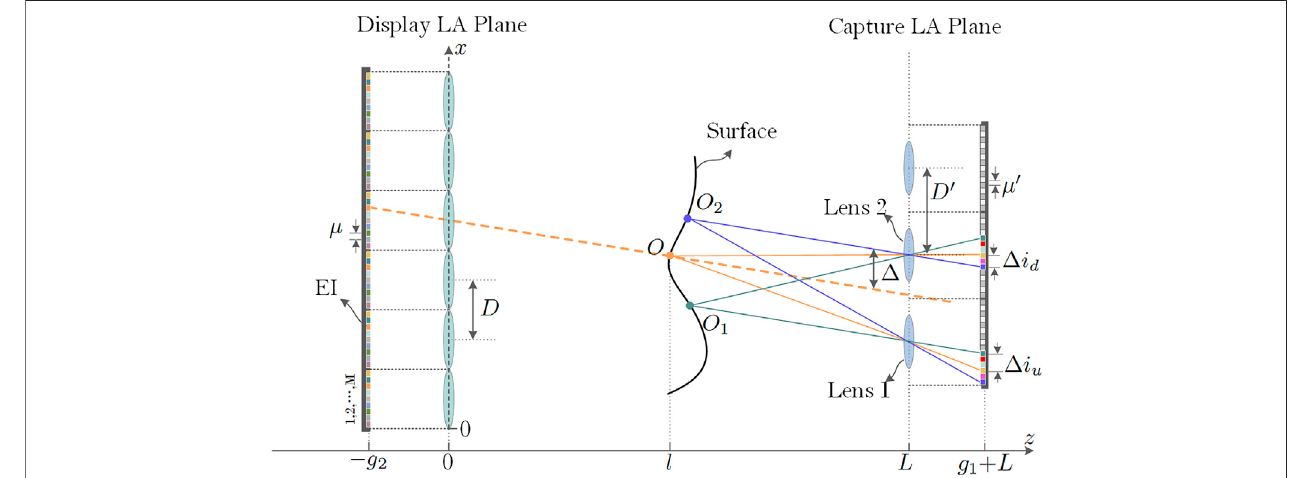
FIGURE 3 | Errors in capture and display rays.